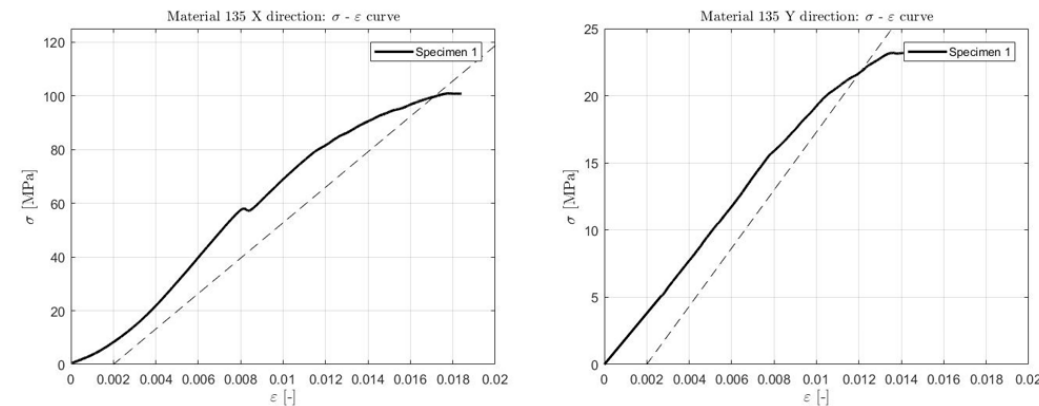
Figure 13. Material 135 tensile tests.